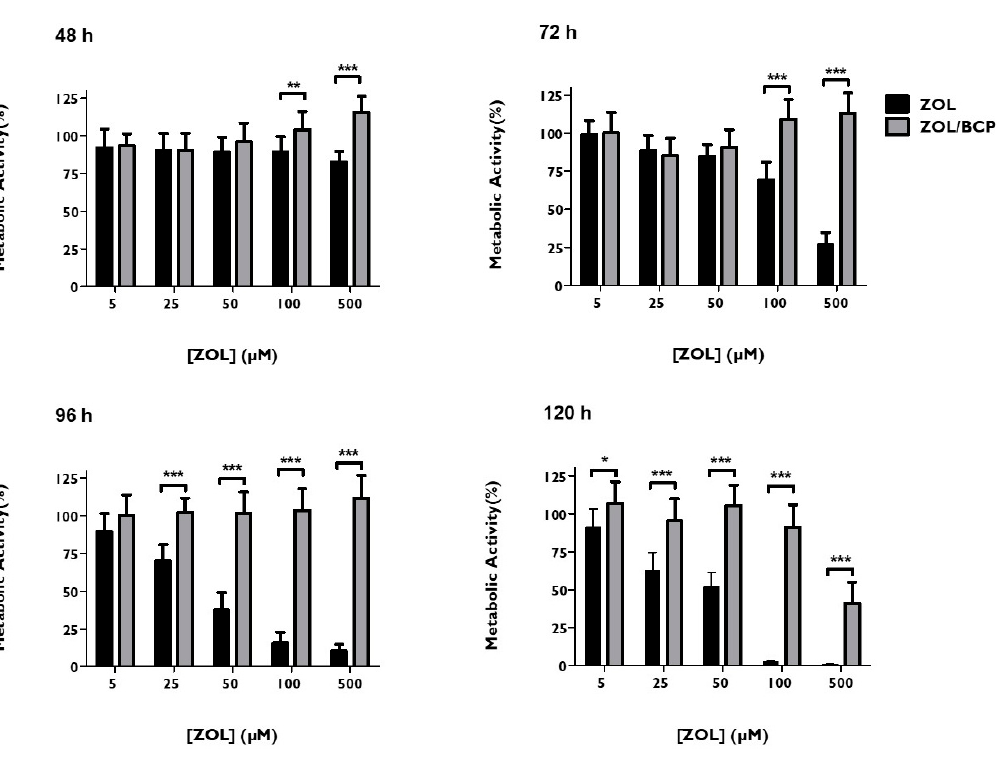
Figure 4. HGF metabolic activity, 48 h, 72 h, 96 h and 120 h after treatment with ZOL and with ZOL / BCP. The results represent the mean and standard deviation of at least six tests. Significant di ff erences are represented with *, where * means p < 0.05, ** means p < 0.01, and *** means p < 0.001.